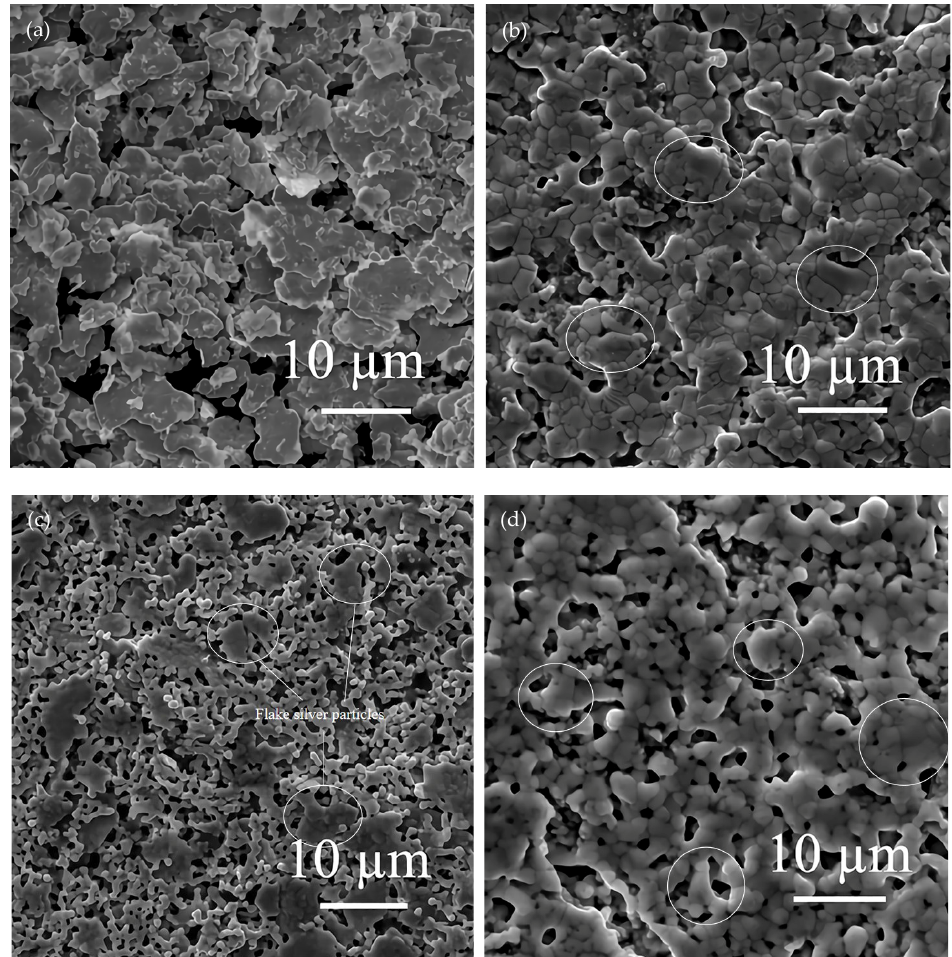
Figure 5. Surface morphology of sintered silver pastes at different temperatures. Images in ( a ) and ( b ) are for the silver paste with flake silver powder sintered at 600 and 800 °C, respectively. Images in ( c ) and ( d ) are for the silver paste with mixed silver powder sintered at 600 and 800 °C, respec ‐ tively.